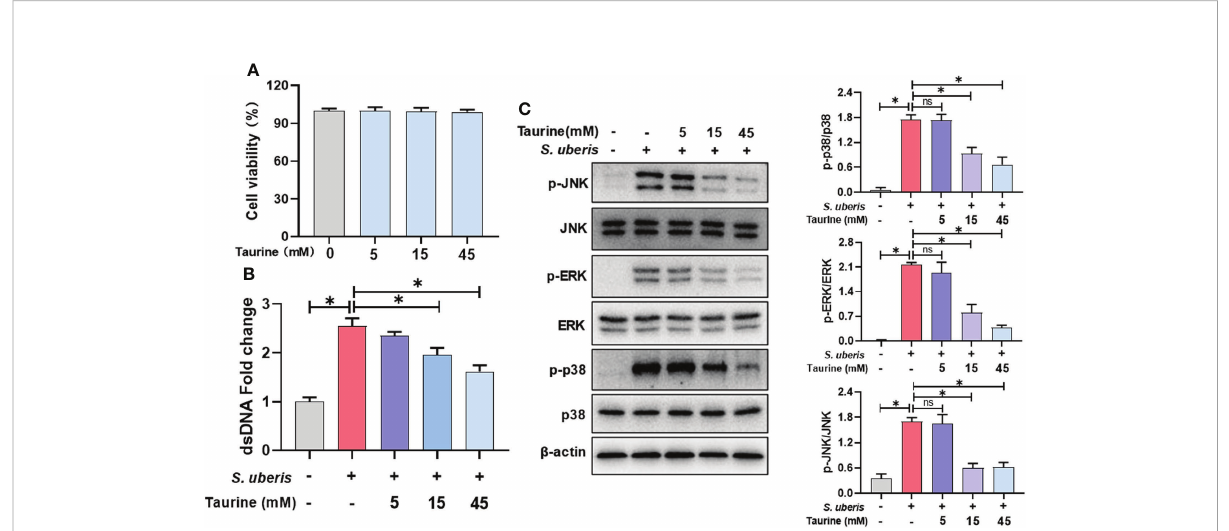
FIGURE 5 Taurine inhibits S. uberis -induced NETs production and MAPK signaling activation. The neutrophils were pretreated with taurine for 1 h before infected with S. uberis at MOI of 10. (A) The cell viabilities treated with taurine for 5 h detected by CCK-8 assay. (B) The dsDNA content in supernatant at 4 h. (C) Immunoblot and statistical analysis of p38, ERK and JNK proteins and phosphorylated proteins at 2 h. Data are presented as mean ± SEM (n = 3). * P > 0.05. ns, not signi fi cant (P >